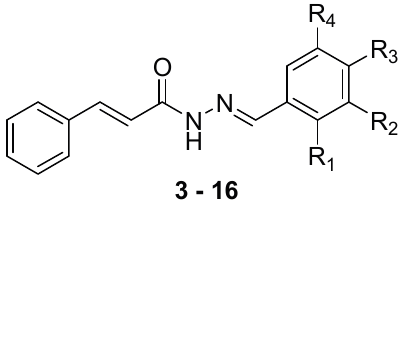
Table 1. In vitro trypanocidal, leishmanicidal and cytotoxic activities of the cinnamic N -acylhydrazone derivatives ( 3 – 16